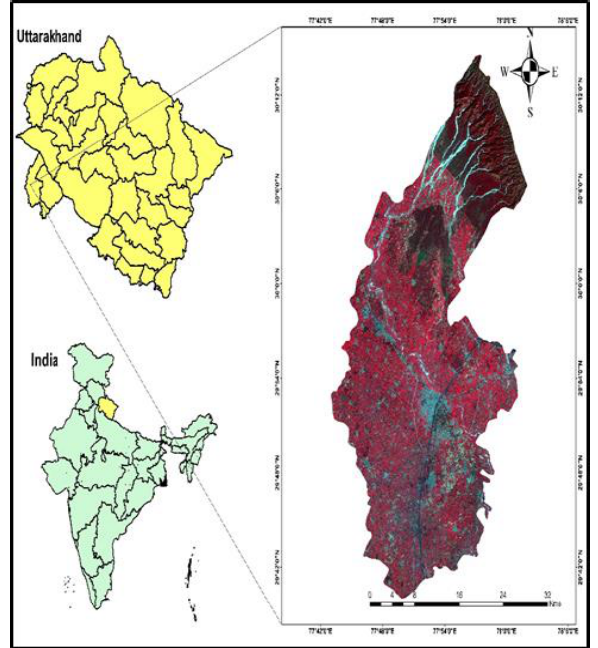
Figure 1. False colour composite (FCC) of the study area using Sentinel-2 image.